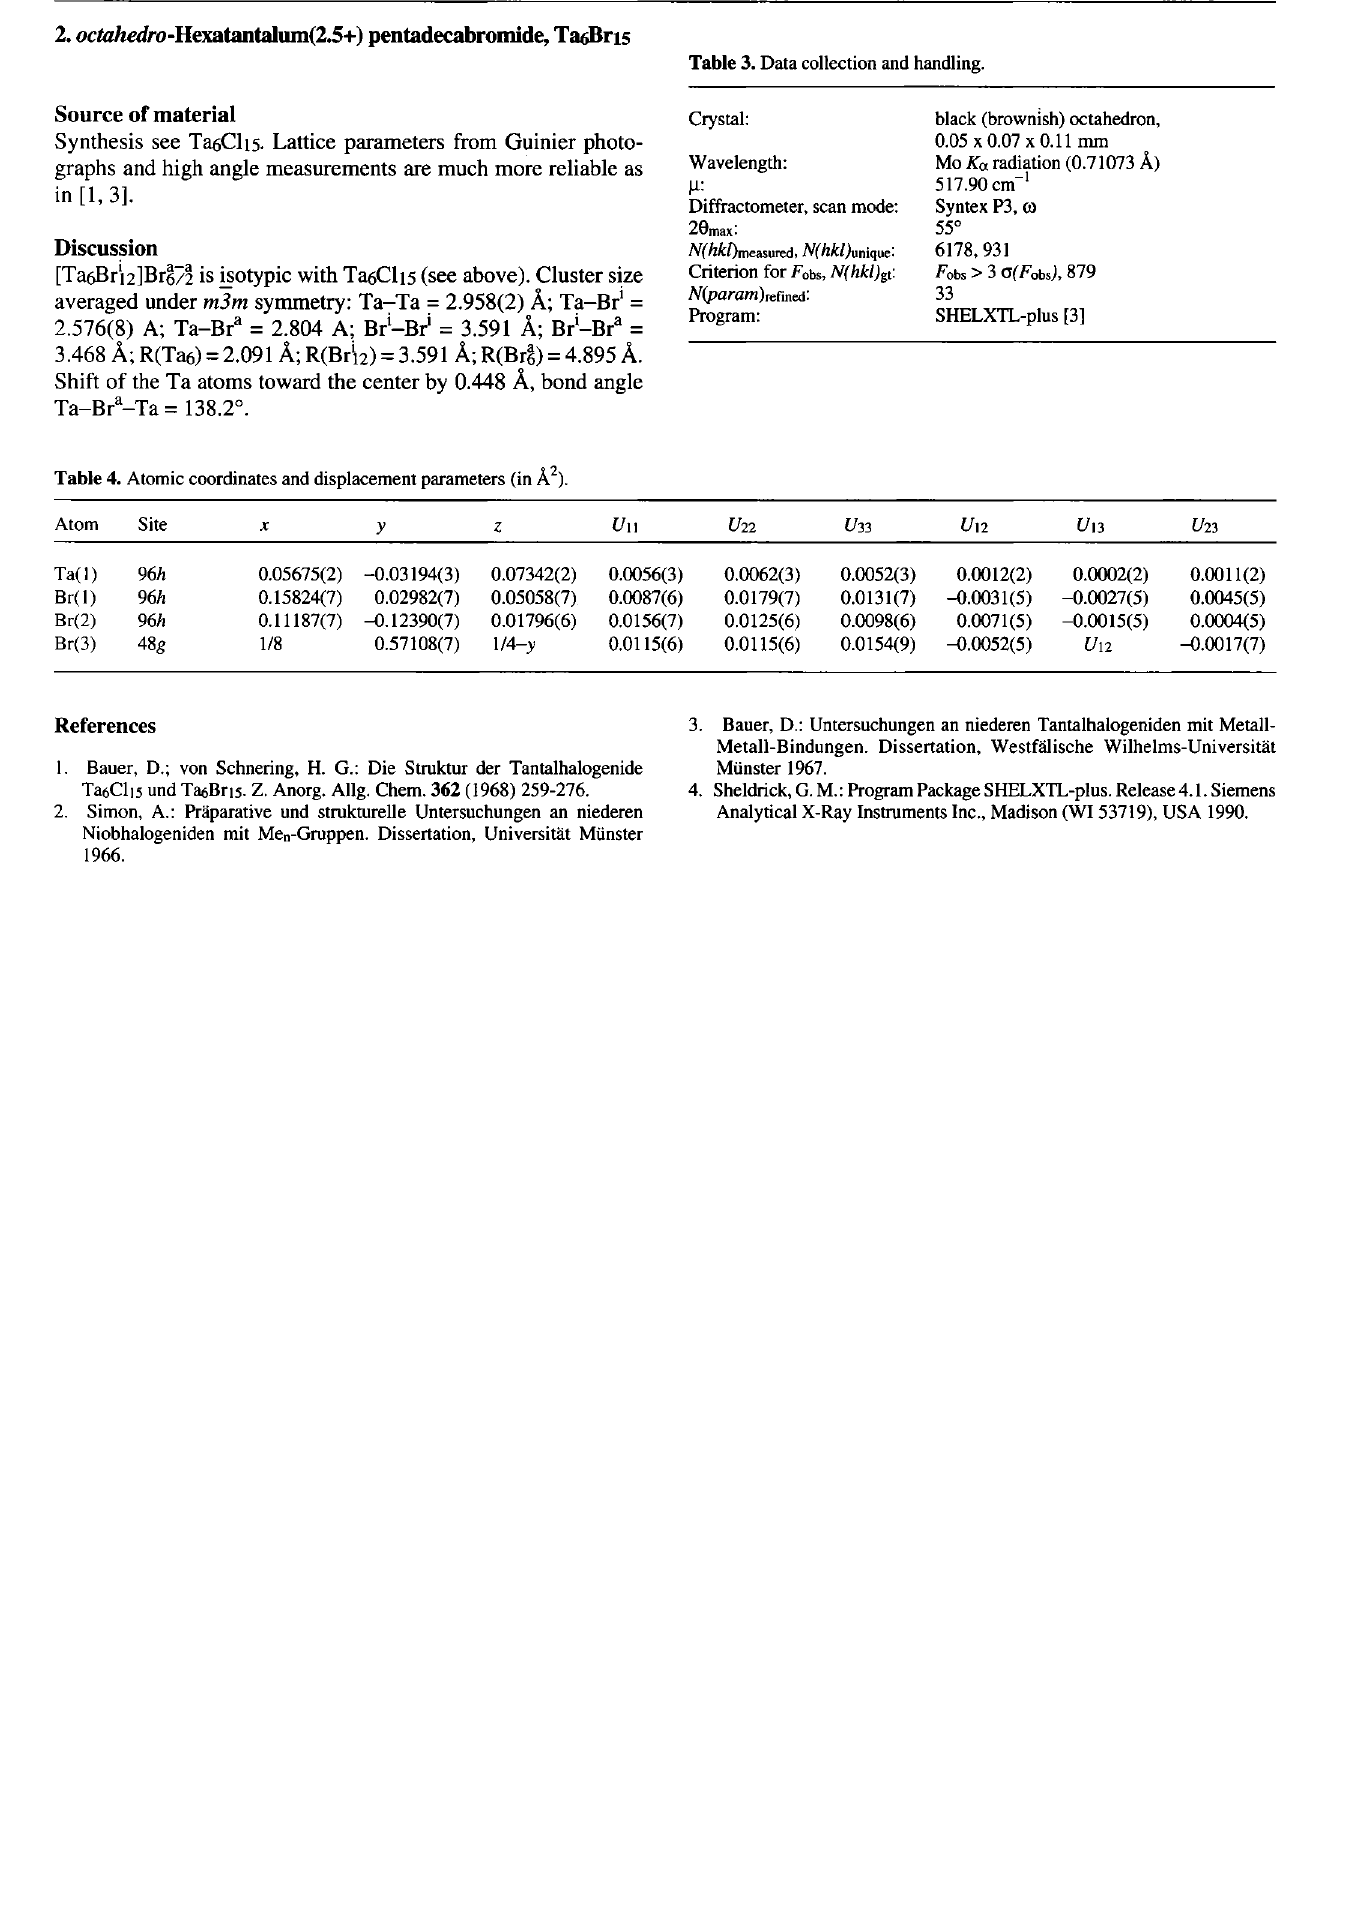
Table 4. Atomic coordinates and displacement parameters (in Â 2